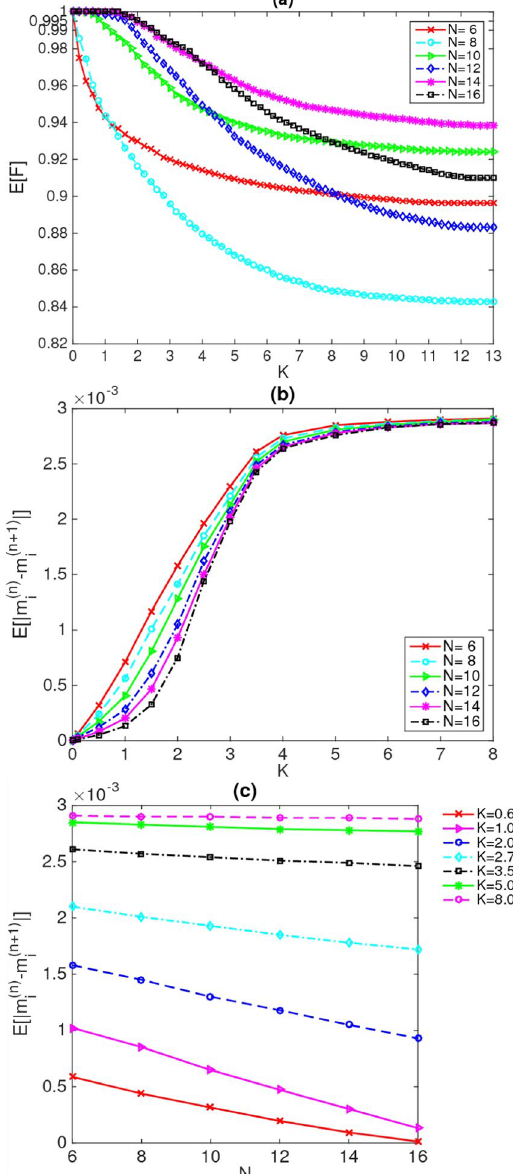
Figure 2. ( a ) Average fidelity as a function of the disorder strength K for system sizes from 6 to 16. The system sizes N are indicated in the legend. ( b ) Average difference as a function of the disorder strength K . ( c ) Average difference as a function of the system size N for different values of the disorder strength K . The values of K are indicated in the legend. In the ergodic phase (at small K ), where the eigenstates are thermal, these differences vanish exponentially in N as N increases, whereas they remain large in the localized phase (at large K